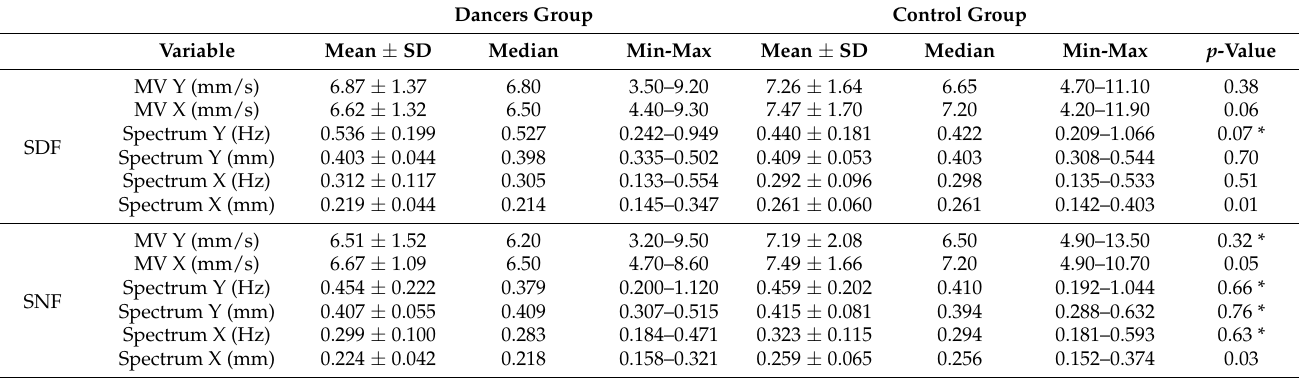
Table 3. Comparison of results obtained in the semi-tandem position with the dominant foot in front (SDF) and with the non-dominant foot in front (SNF) in the dancer and control